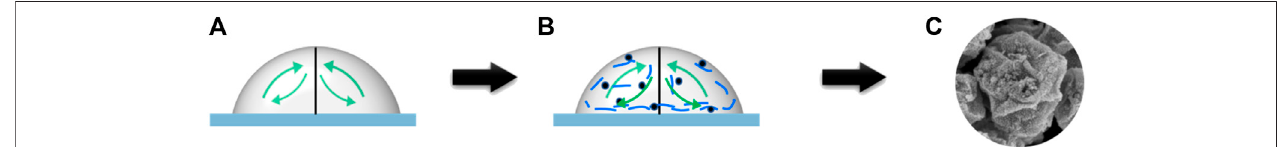
FIGURE 4 | Schematic illustration of the formation mechanism of hybrid MXene/C nanospheres. (A) Marangoni fl ow occurs in the deposited droplet due to the temperaturegradientonheatsubstrate. (B) Carbonnanoparticles-anchoredMXenenanosheetsmigratingfromtheinteriortotheedge; (C) MXene/Cprecipitatingatthe edge and shaping along the droplet surface for a spherical